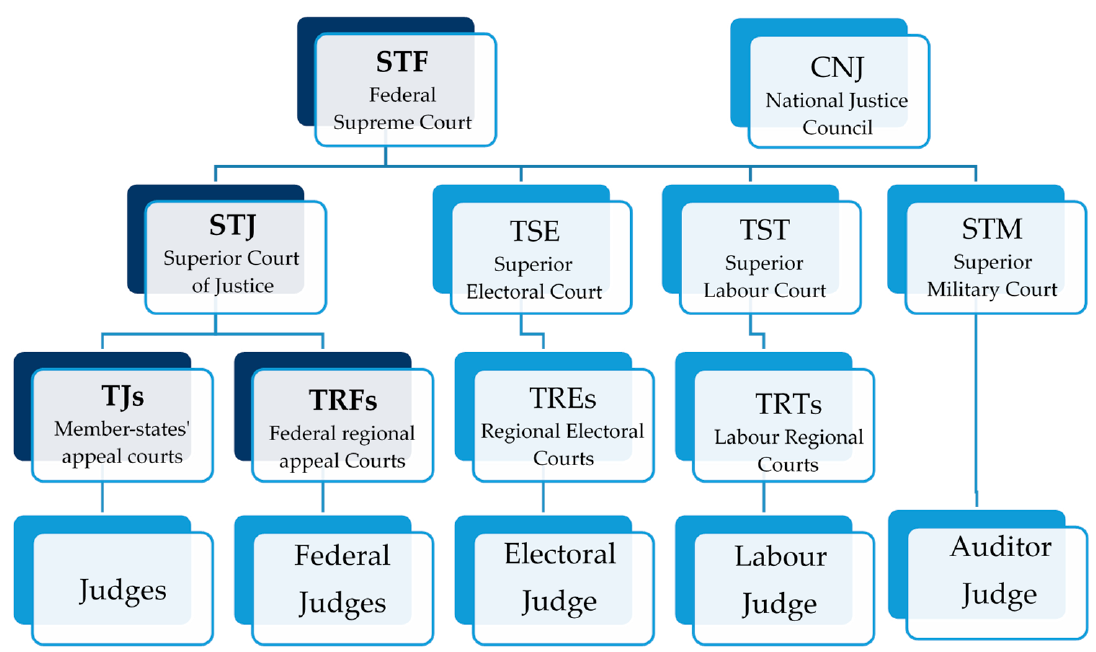
Figure 1. Brazilian judiciary’s structure. All the figures in this article have been made by the authors.